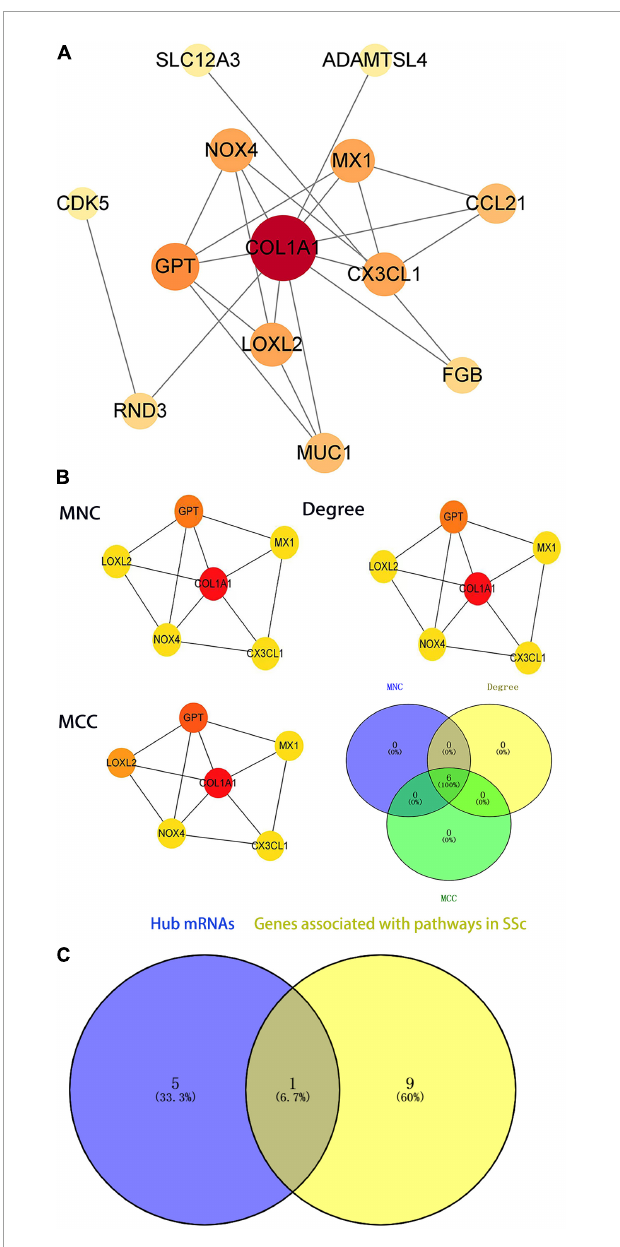
FIGURE7 Identification of the hub genes in the protein–protein interaction (PPI) network. (A) PPI network of differentially expressed genes (DEGs) related to systemic sclerosis (SSc). The ceRNA networks of DEG encoded proteins are composed of 18 nodes and 19 edges. Each node represents a protein, and each edge represents a protein-protein association. (B) Identification of the hub genes of DEGs associated with SSc in the PPI network. The hub genes are identified by three algorithms: Maximal Clique Centrality (MCC), Degree, and Maximum Neighborhood Component (MNC). The color density represents the score of the algorithm. (C) The blue part presents the hub genes of the PPI network. The yellow part shows the genes associated with SSc-related pathways ( P < 0.05 in KEGG). The middle part represents the overlapping hub genes of the two groups. MCC, maximal clique centrality; MNC, maximum neighborhood